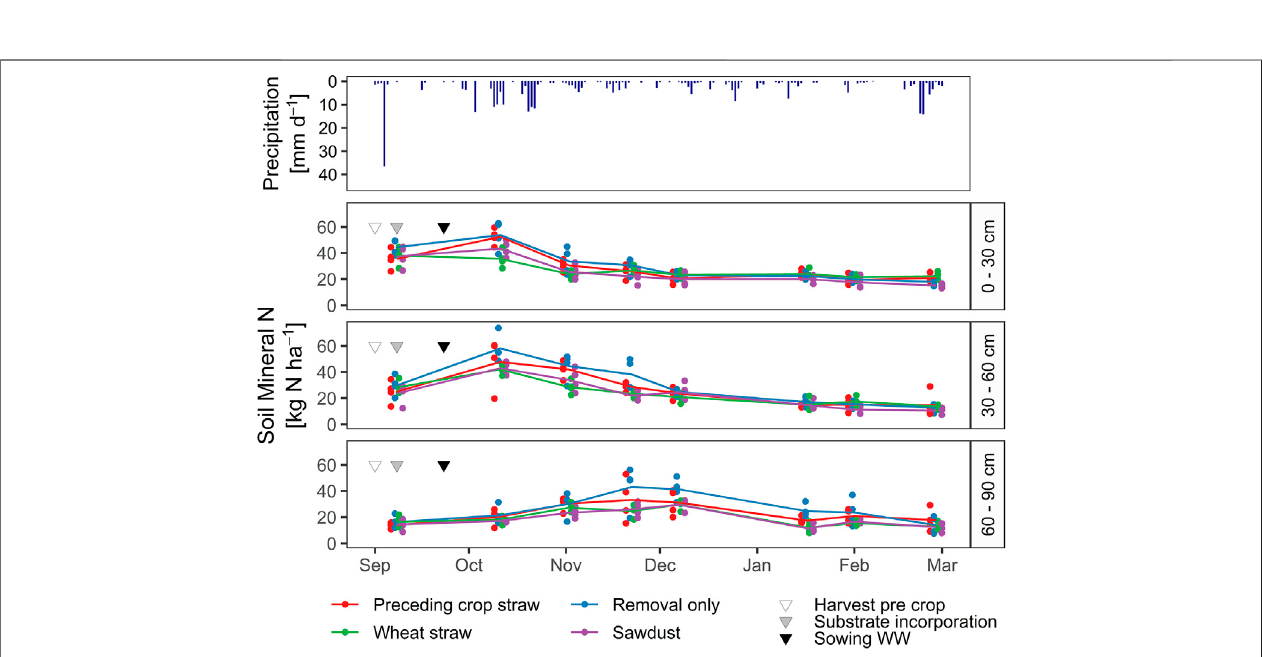
FIGURE4| ExampleSMNdynamicsfrom2016/17afterfababeanforthethreesoillayers0 – 30,30 – 60,and60 – 90 cmdepth;pointsindicatemeasured contents; lines indicate linear interpolated mean values.